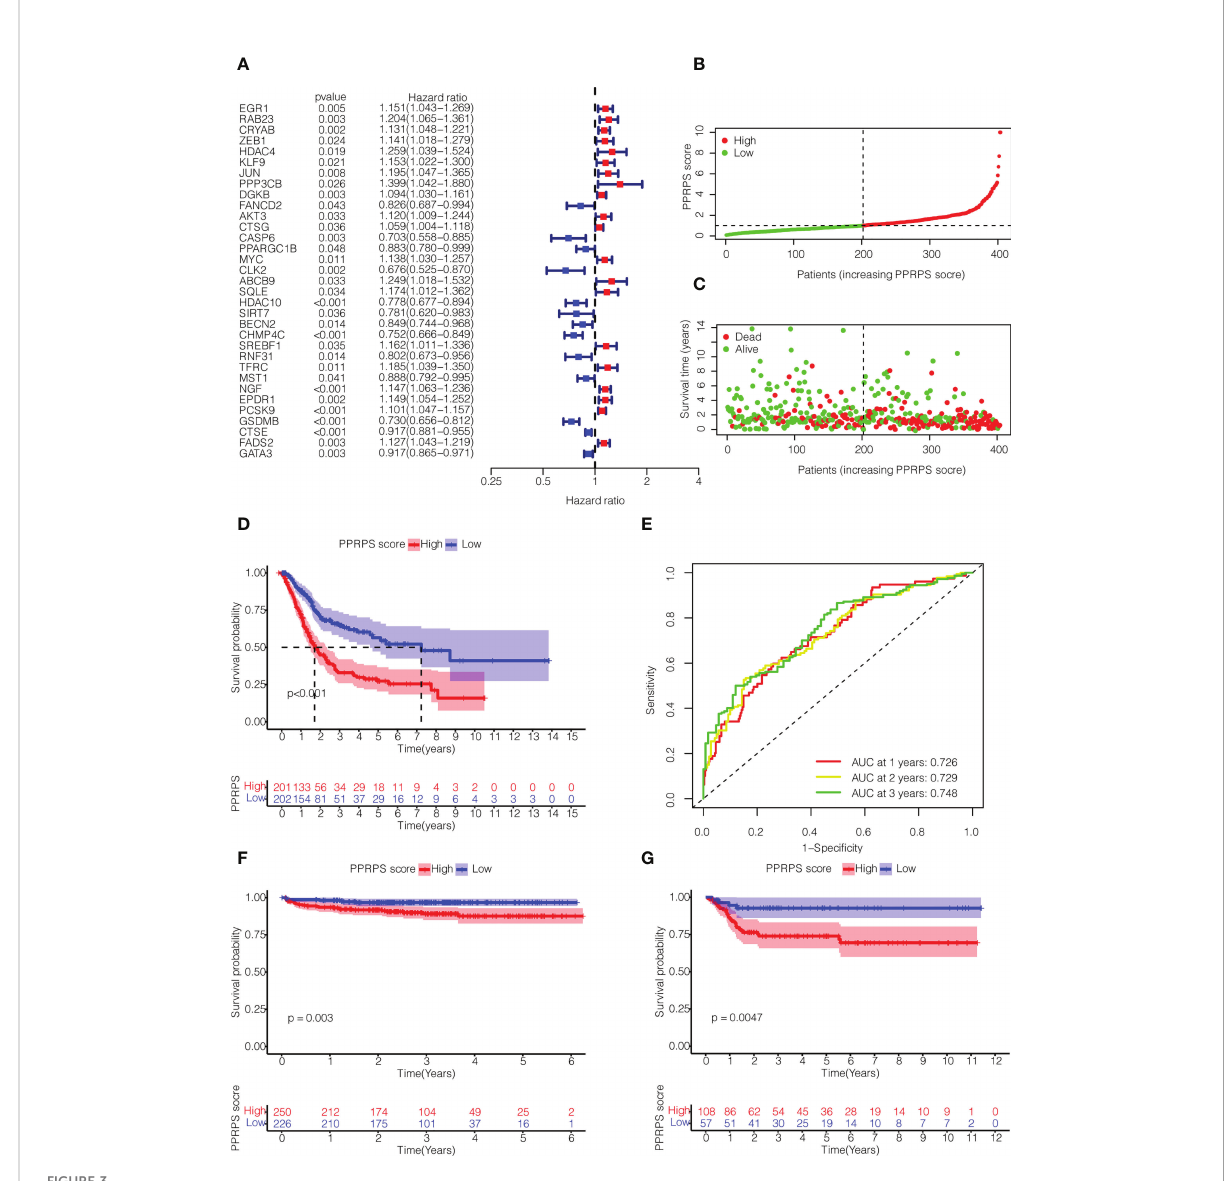
FIGURE 3 Construction of the Pan-PCD-related prognostic signature in bladder cancer. (A) Univariate Cox regression analysis of Pan-PCD-related DEGs. (B) Distribution of bladder cancer patient survival based on TCGA cohort data. (C) The distributions of status PPRPS showed that the number of deaths increased as the PPRPS increased. (D) Kaplan – Meier (K-M) curves of the high-PPRPS and low-PPRPS groups. Patients in the high-PPRPS group had a poor prognosis compared to the low-PPRPS group (p<0.001). (E) AUC of time-dependent ROC curves. (F) K-M curves of the high- and low-PPRPS groups in ArrayExpress cohort E-MTAB-4321. (G) K-M curves of the high- and low-PPRPS groups in GEO cohort